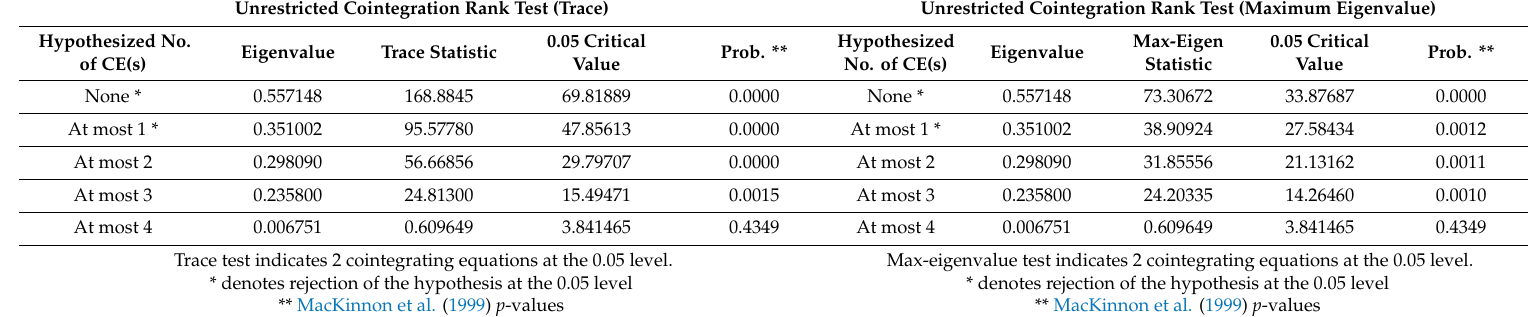
Table 8. Johansen cointegration